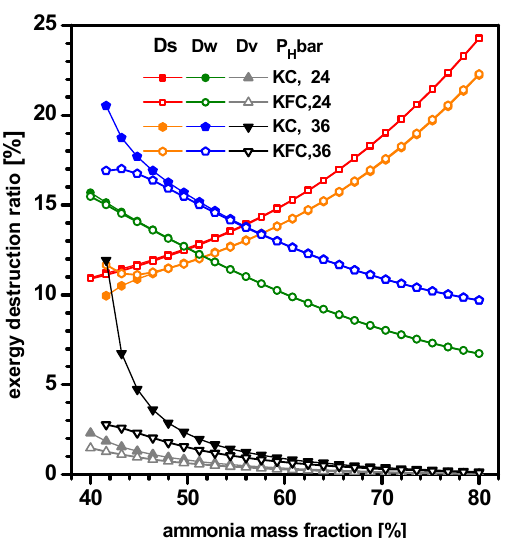
Figure 8. Dependence of Ds , Dw , and Dv on ammonia mass fraction for P H = 24, 36 bar in the KC and KFC.